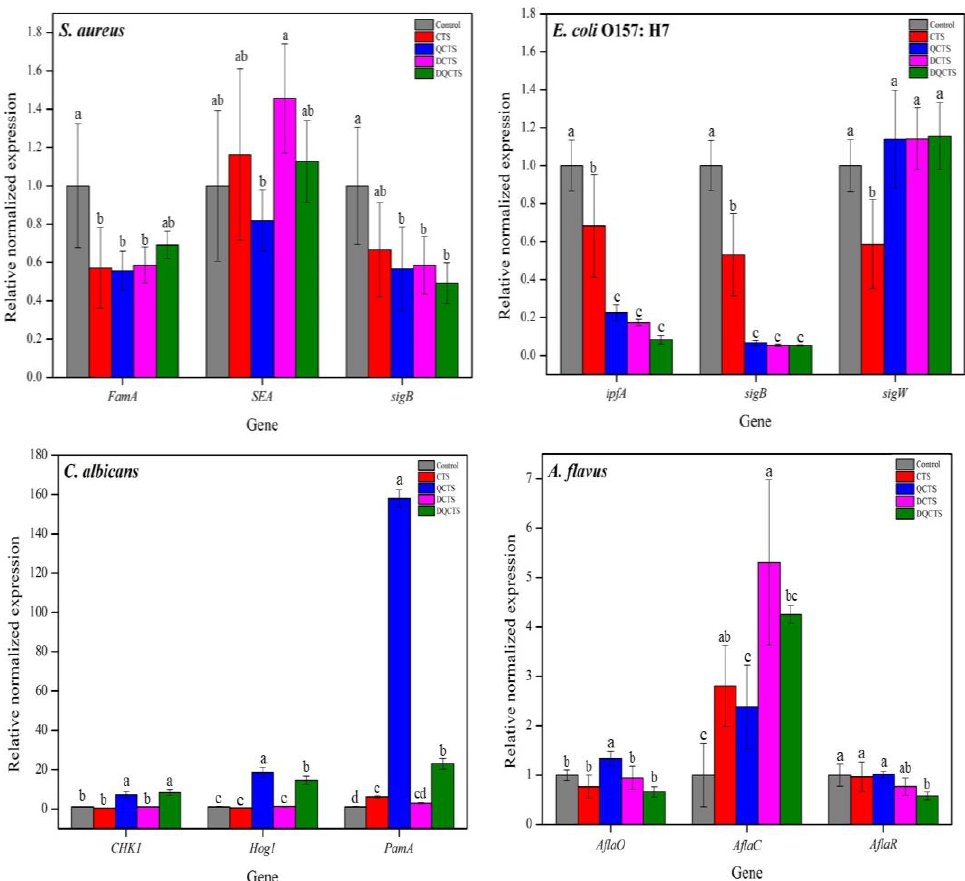
Figure 4. Comparison of relative expression levels of each gene treated with chitosan compounds using qRT-PCR in S. aureus , E. coli O157: H7, C. albicans , and A. flavus . Each bar represents relative expression levels compared to the GAPDH values (gray color, control). The values were presents as mean ± standard deviation ( n = 3). a – d means in each bar with a different letter is significantly different by Duncan’s multiple range test at p < 0.05. CTS: chitosan, QCTS: quaternized chitosan, DCTS: fully deacetylated chitosan, DQCTS: fully deacetylated quaternized chitosan.